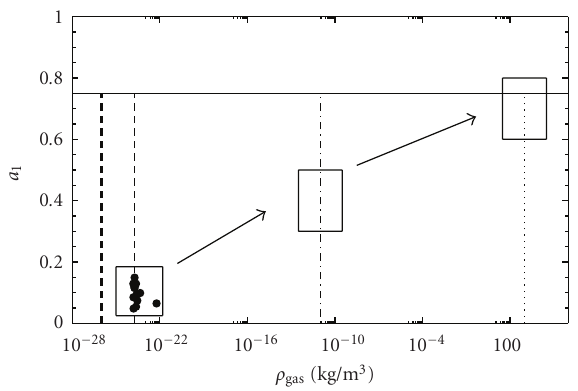
Figure 6: Density versus a 1 : predictions on the behavior of a 1 . The horizontal black bold line indicates the Newtonian-limit, a 1 → 3 / 4 which we expect to be realized on scales comparable with Solar System. Vertical lines indicate typical approximated values of matter density (without dark matter) for di ff erent gravitational structures: Universe (bold dashed) with critical density ρ crit ≈ 10 − 26 kg / m 3 ; galaxy clusters (dashed line) with ρ cl ≈ 10 − 23 kg / m 3 ; galaxies (dot-dashed) with ρ gal ≈ 10 − 11 kg / m 3 ; sun (dotted) with ρ sun ≈ 10 3 kg / m 3 . Arrows and boxes show the predicted trend for a 1